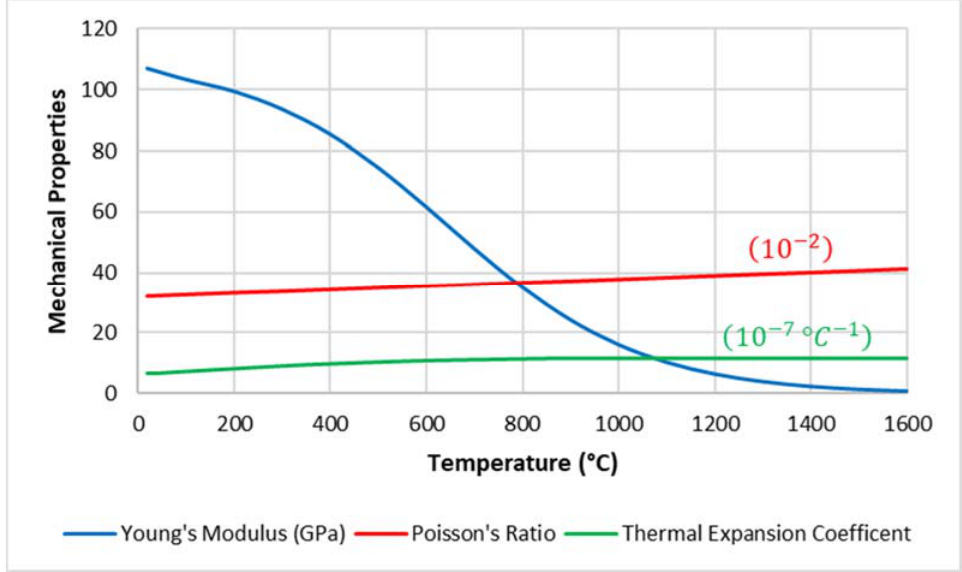
Figure 4. Chart displaying the following mechanical properties as functions of temperature for Ti-64; Young’s Modulus [17], Poisson’s Ratio [17], and the coefficient of linear thermal expansion [17].